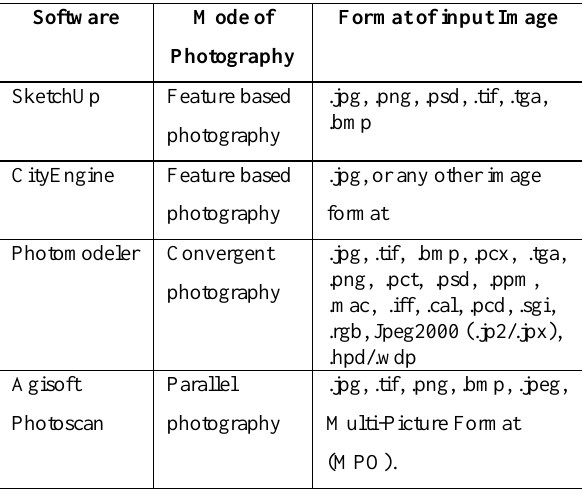
Figure 6 . Camera calibration grid (Chess board) in Agisoft Lens